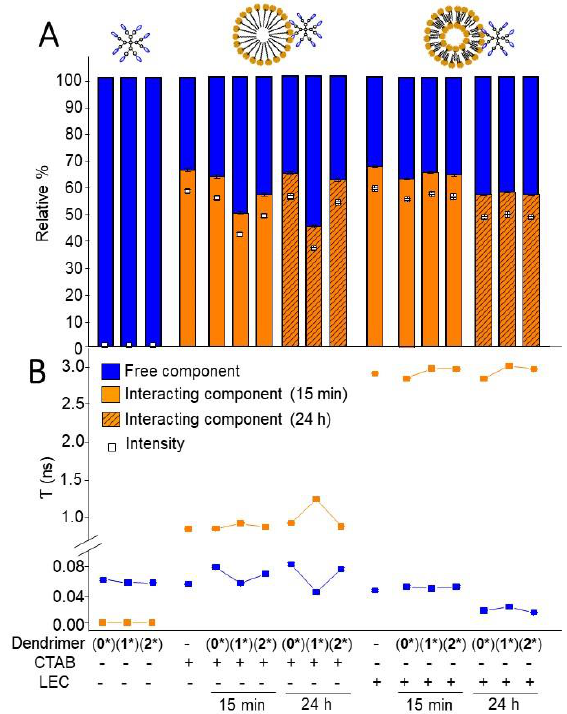
Figure 3. Parameters obtained from the analysis of CAT12 EPR spectra of the unlabeled dendrimers G n -Py in the absence and presence of the model membranes (CTAB micelles and LEC liposomes). ( A ) Relative percentages of interacting component (bars) for CTAB and LEC samples in the absence and presence of G n -Py dendrimers at 15 min and 24 h equilibration times, and intensity values (squares), in percentages, assuming 100% as the highest intensity. ( B ) Microviscosity parameter, τ, for both the Free and Interacting components.